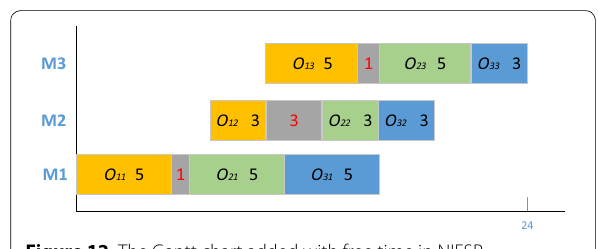
Figure 12 The Gantt chart added with free time in NIFSP